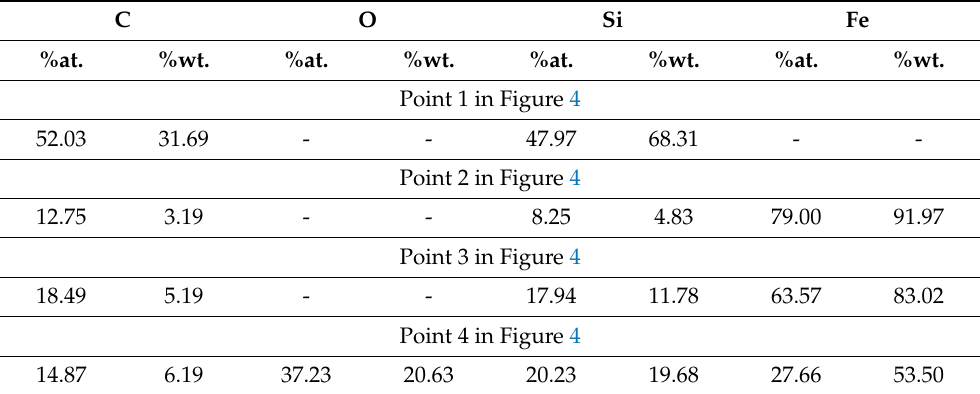
Table 4. The result of the EDS point analysis (marking points according to Figure 4).